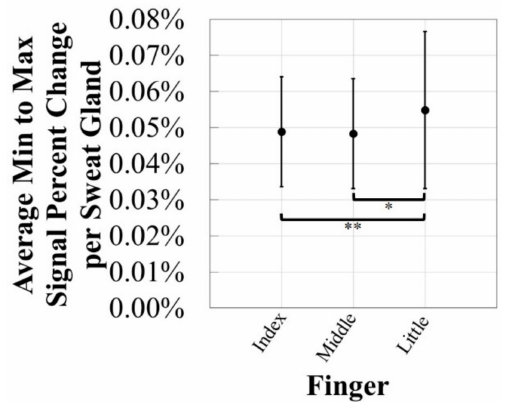
Figure 8. The average minimum to maximum EDA signal percent change per sweat gland for comparison of EDA waveforms from the distal phalanx of the index, middle, and little fingers on the palm. Standard deviations are shown and one-tailed t -test results with p -values < 0.05 (*) and p -value < 0.10 (**) are indicated. For each value n =